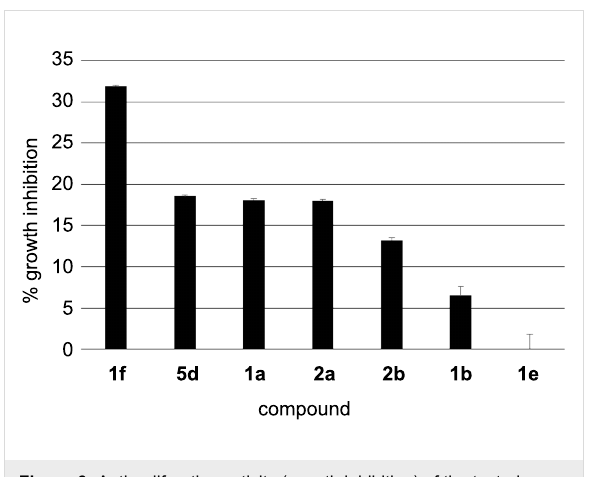
Figure 6: Antiproliferative activity (growth inhibition) of the tested com- pounds 1a , b , e , f , 2a , b and 5d at concentration 10 − 5 M and 72 h in A2058 human melanoma